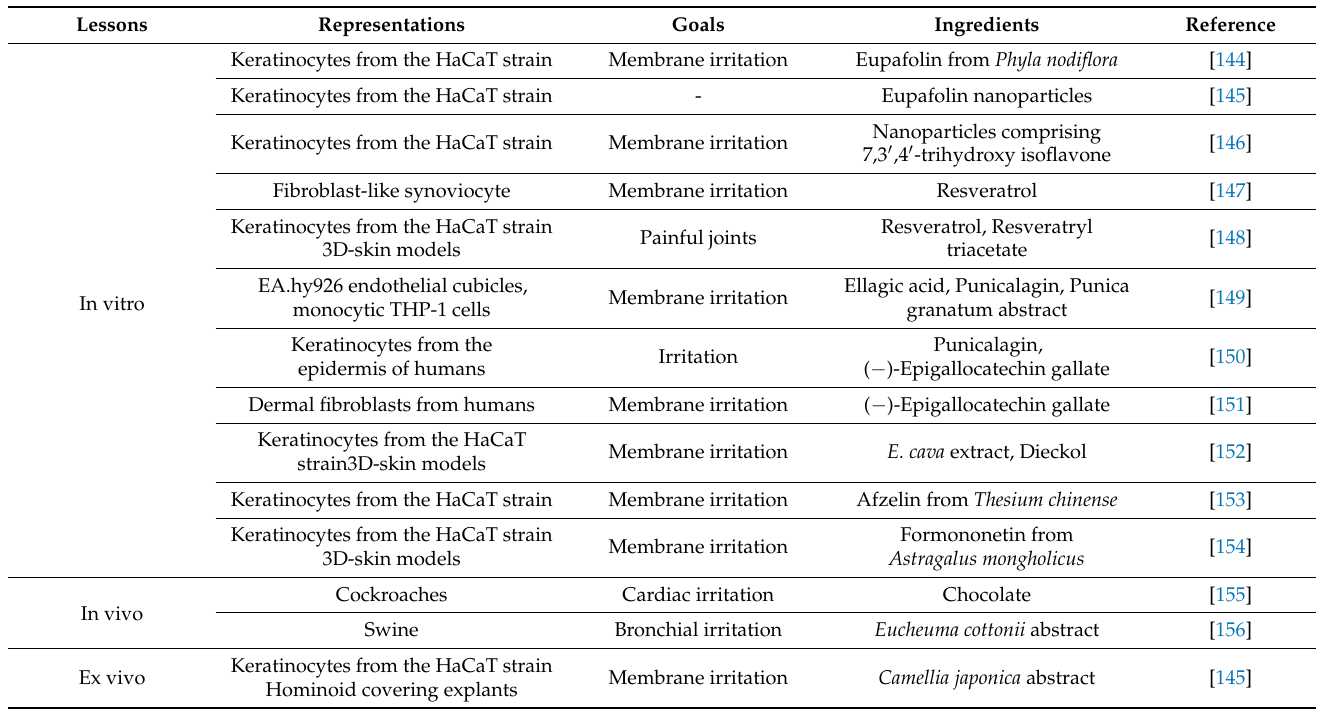
Table 3. Protective effects of plant extracts and phenolic compounds against oxidative stress and inflammation induced by airborne particulate matter